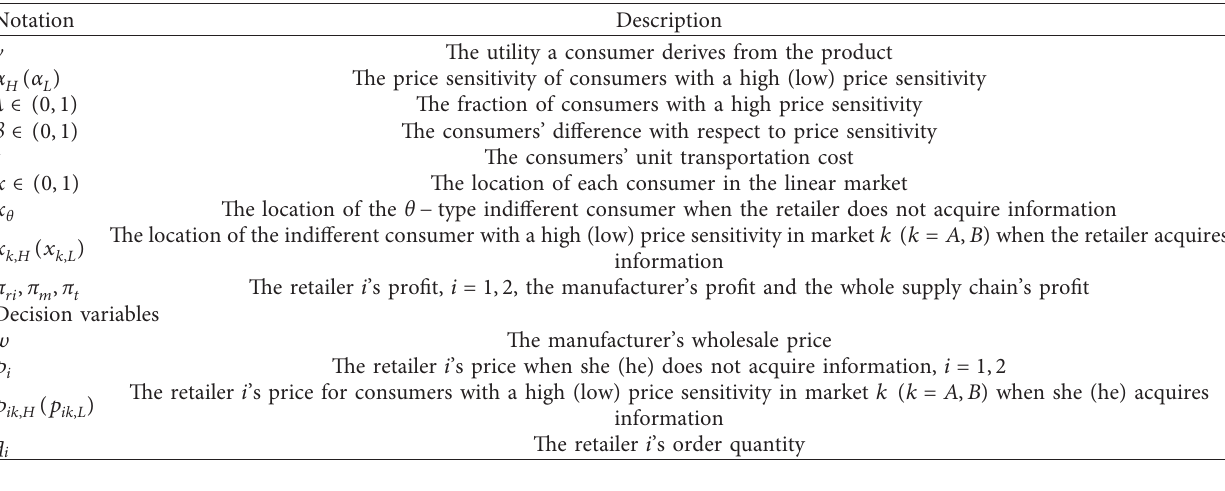
Table 1: Notations.